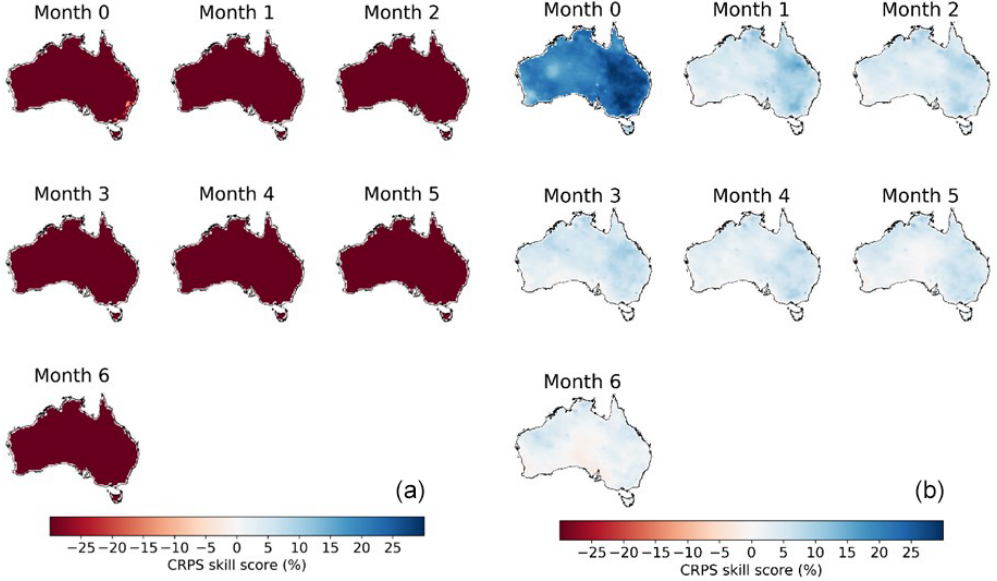
Figure 5. CRPS skill scores in (a) raw and (b) calibrated forecasts at seven lead times during 1990–2019.